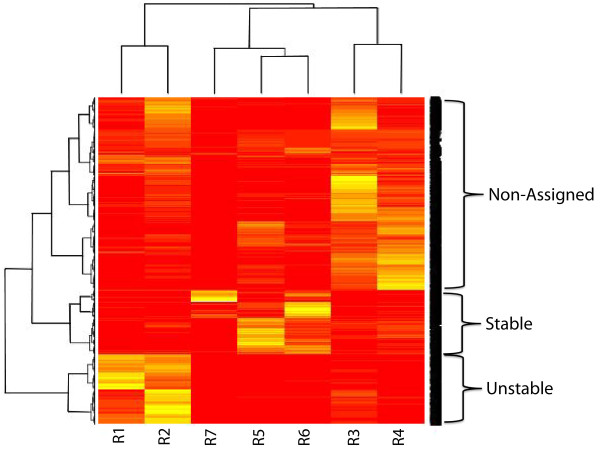
Heat-map and cluster analysis generated from the output of the Yen experiment [[1]]. A Euclidean distance metric was used for the cluster analysis. Bright (yellow) colouring in the heat-map represents a value approaching 1, with values approaching 0 having a dull (red) colouring. Labels on the right show how the data can naturally be broken up into groups of stable and unstable proteins, with the remainder being classed as “non-assigned”.